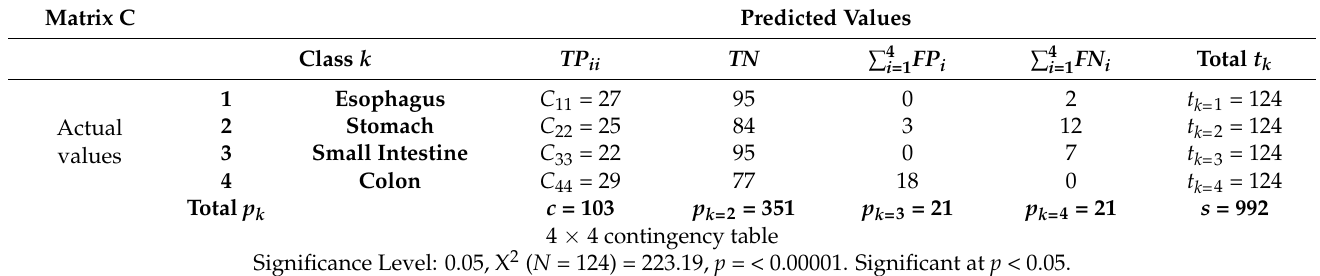
Table 6. Report from testing 496 frames (124 not seen before frames of each organ) with CNN Model 3.